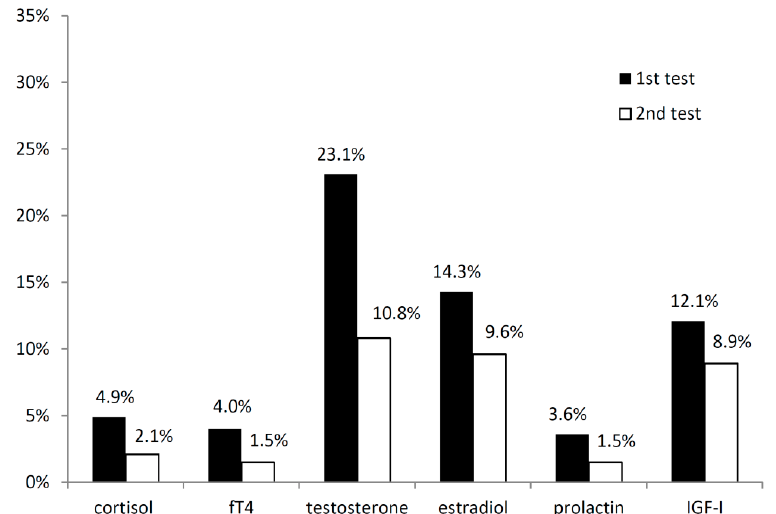
Figure 1. Lowered basal laboratory values in the first hormonal assessment after a median of three months (first test) and the follow-up after a median of seven months (second test) in patients after traumatic brain injury (TBI) and subarachnoid hemorrhage (SAH). Abbreviations: fT4, free thyroxine; IGF-I, insulin-like growth factor I.